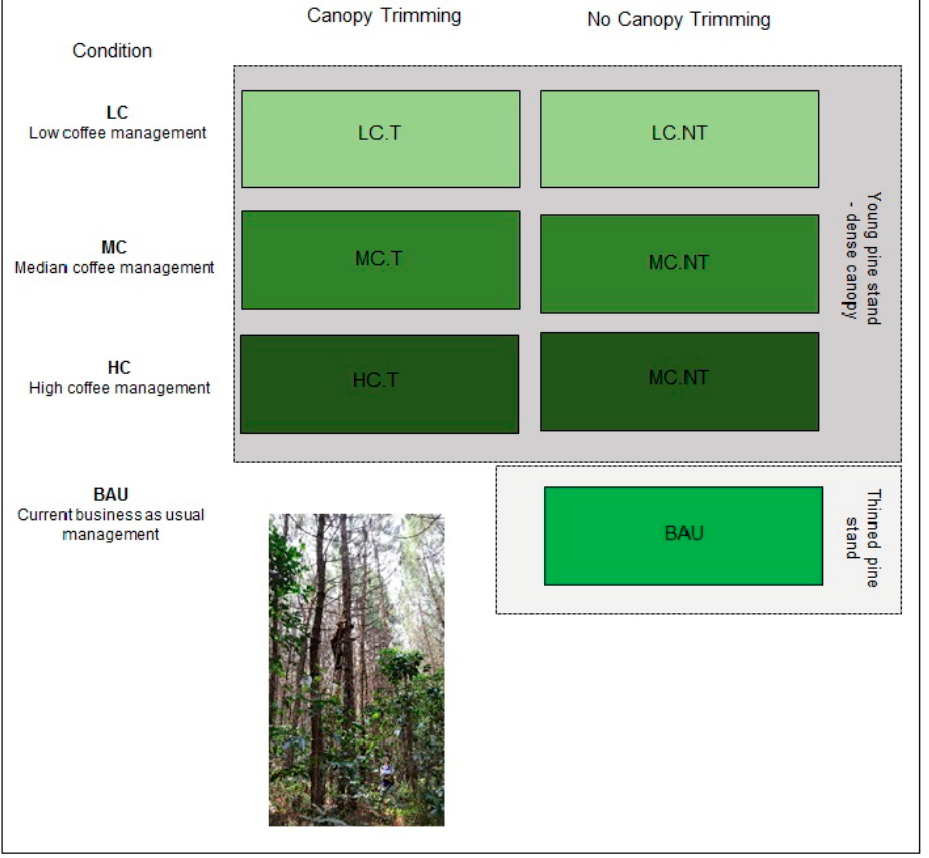
Figure 3. Experimental platform. Consists of four plots spanning the range of coffee management intensities present within the forest (see text for details). The LC, MC and HC are divided into two blocks (with a small 10 m buffer between the two halves) to allow for pairwise comparison of pine tree canopy trimming. Pine tree canopy trimming was started in late February 2019 and completed in May in 2019. Plots are located across the western section of the forest with a minimum of 100 m between each